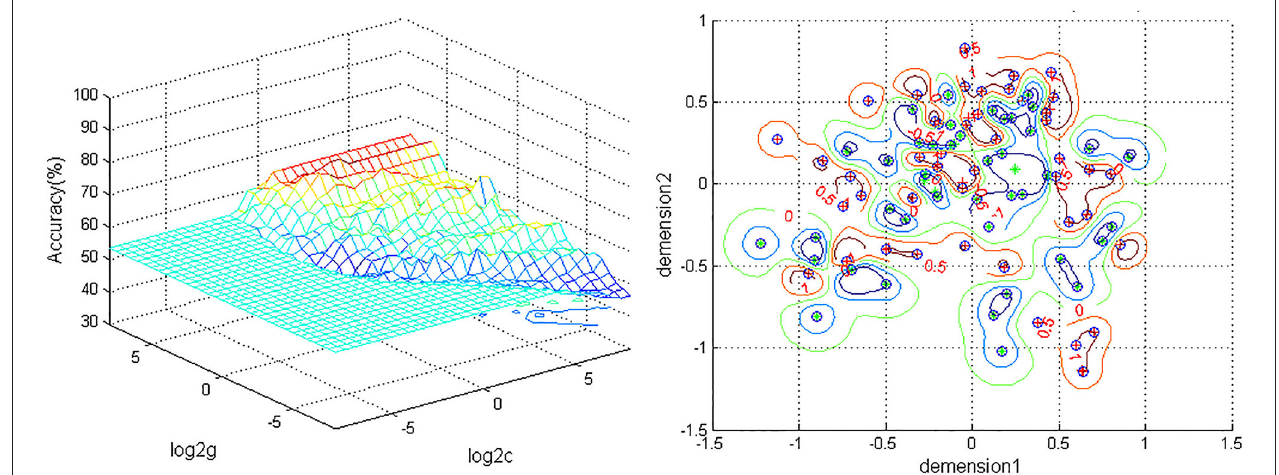
FIGURE 2 | Depiction of classifications based on the SVM using a combination of ReHo values in the left ACC and PG to differentiate MDD patients from HCs. Left: SVM parameters result of 3D view. g, means gamma; c, penalty coefficient; Right, dimension 1 and dimension 2 represent the ReHo values in the left ACC and PG. Green crosses represent MDD patients, and the red crosses represent HCs. SVM, support vector machine; ReHo, regional homogeneity; ACC, anterior cingulum cortex; PG, precentral gyrus; MDD, major depressive disorder; HCs,s healthy